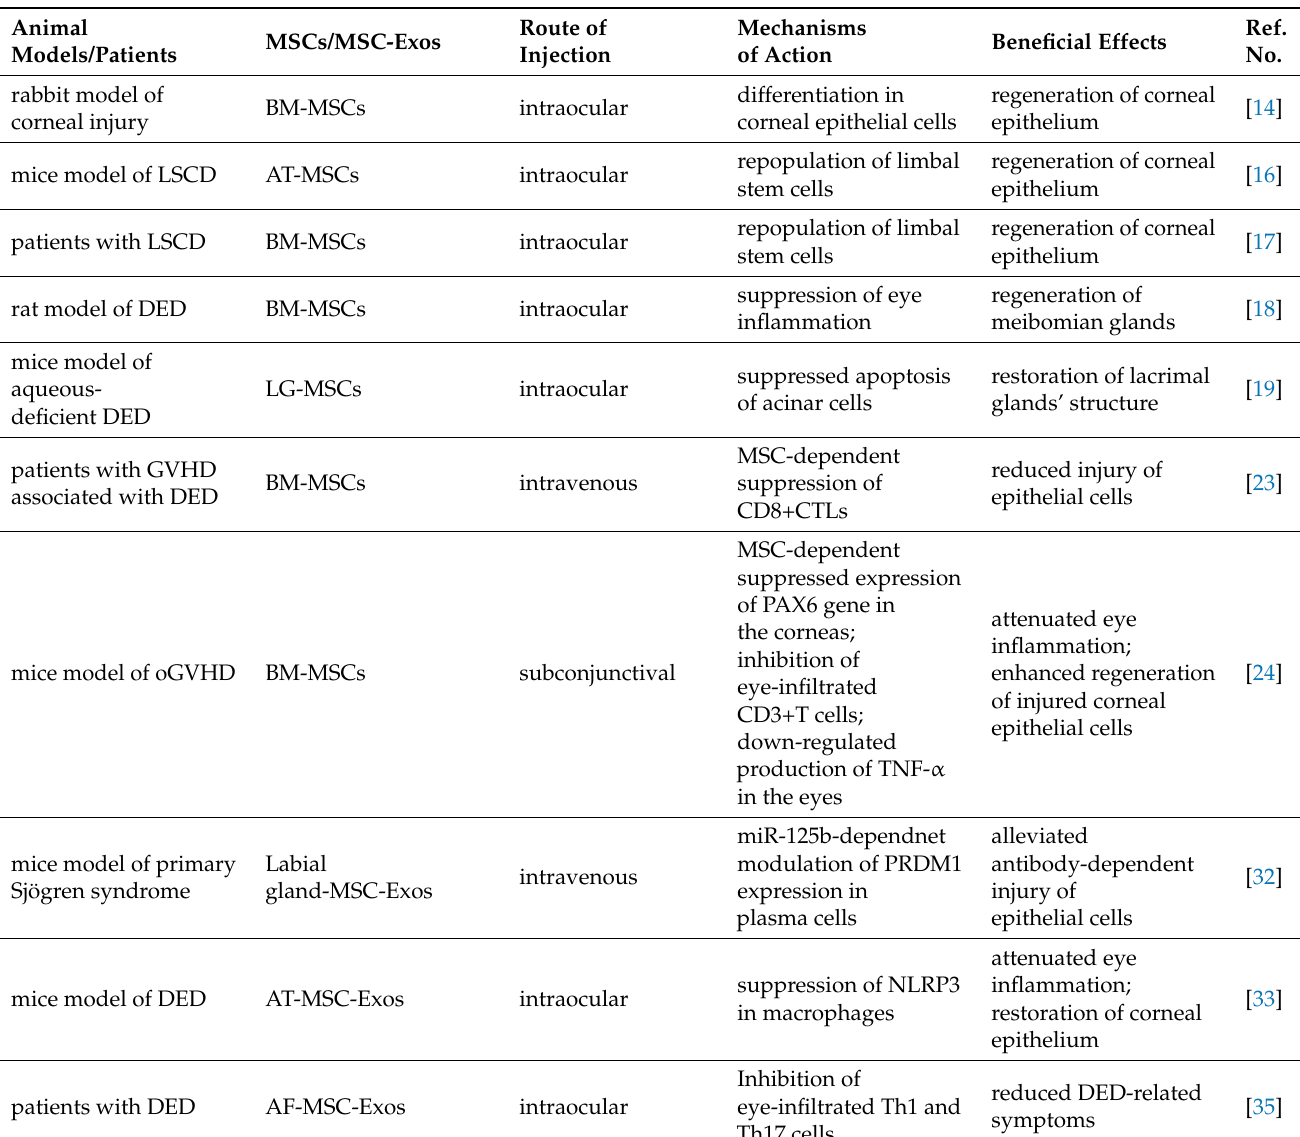
Table 3. Experimental and clinical studies that indicated therapeutic potential of MSCs and MSC-Exos in oGVHD